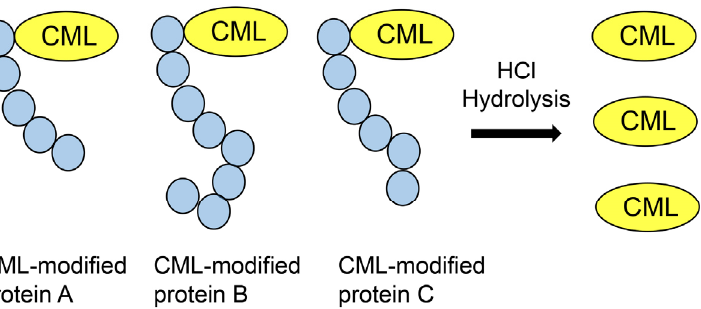
Figure 9. Hydrochloride (HCl) hydrolysis of various CML-modified proteins and collection of free CML.